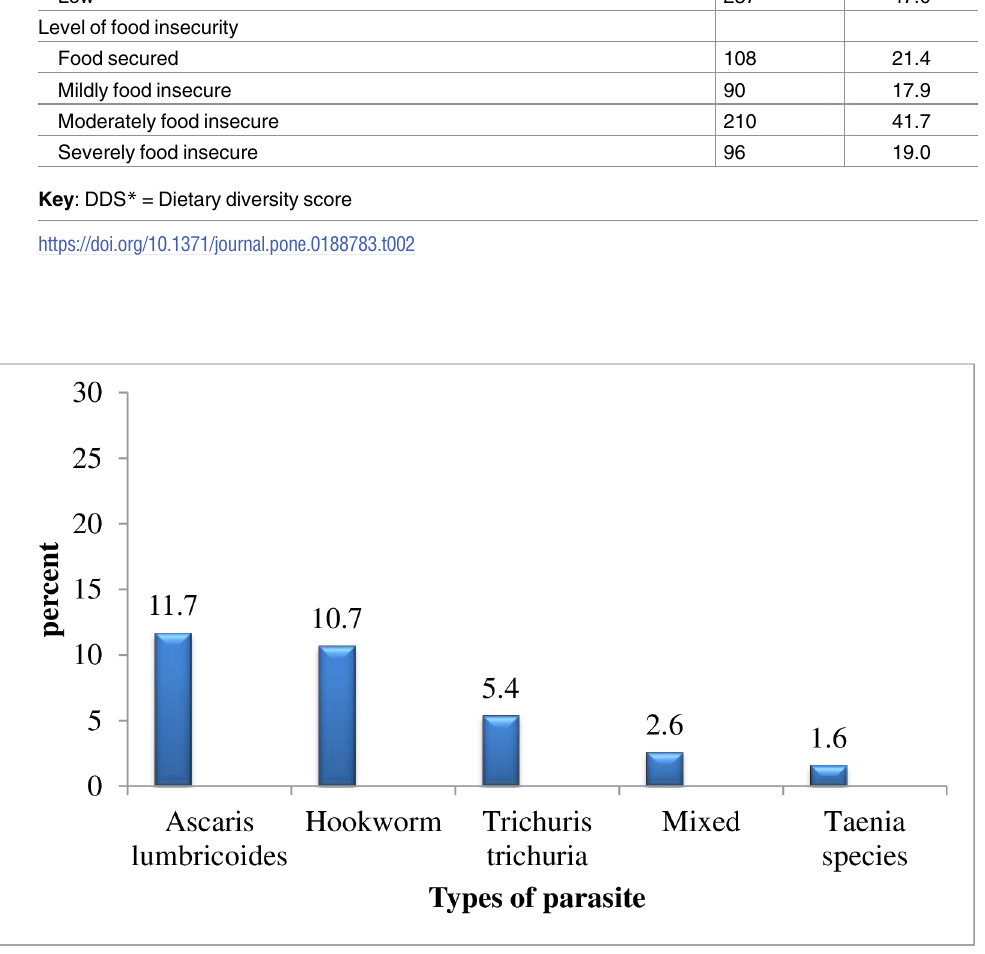
Fig 1. Prevalence of intestinal parasitesamong pregnant women in Lemo district, Southern Ethiopia, 2015 (n = 504). Mixed = co—infection with one or more intestinal parasites , other = Taenia species and Trichuris trichuria